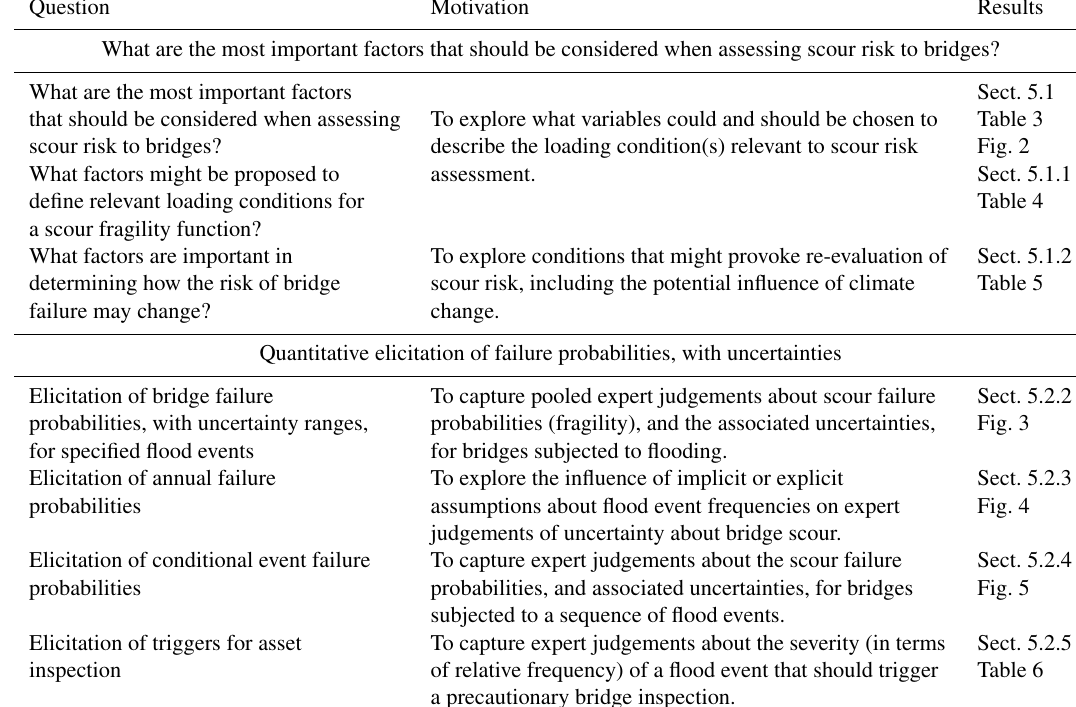
a precautionary bridge